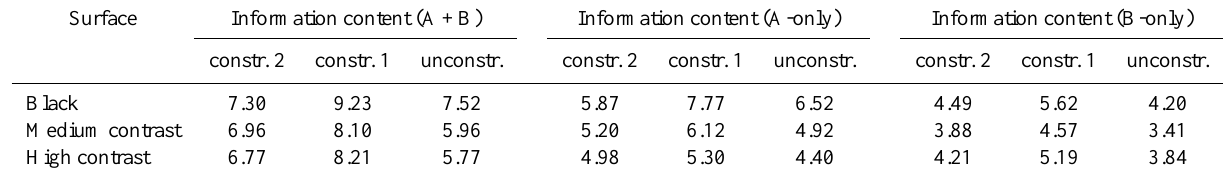
Table 2. Information content per parameter retrieved for different retrieval set-ups. The number of retrieved parameters vary from 3 for the two constrained cases, 5 for the unconstrained cases involving only the A- or the B-band, and 6 for the unconstrained cases using both the A- and